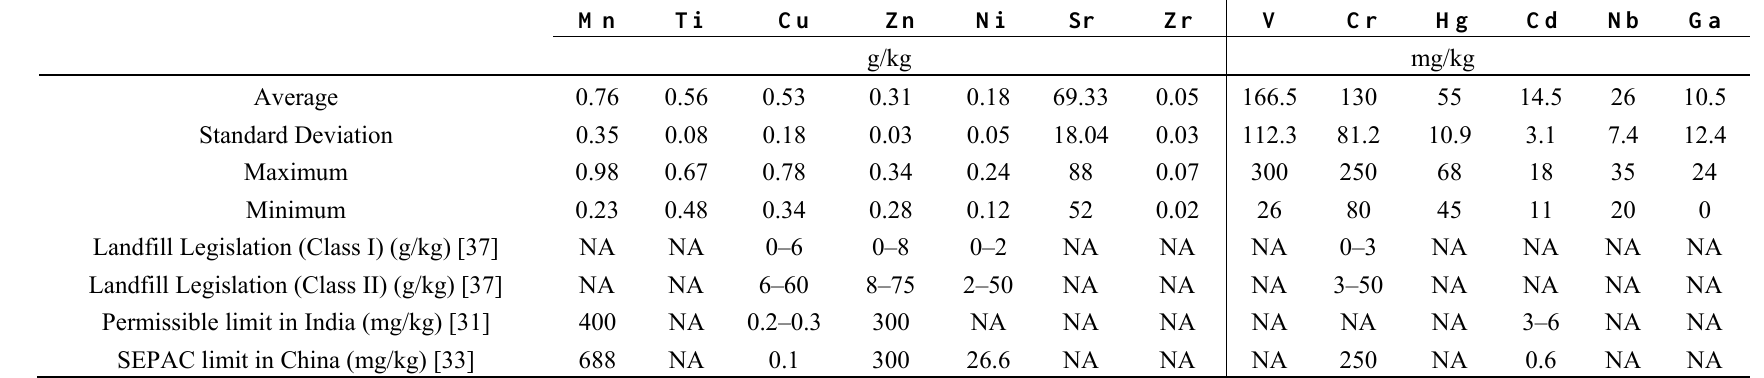
Table 2. Concentration of heavy metals in EMHS and different legislations for sludge utilization.